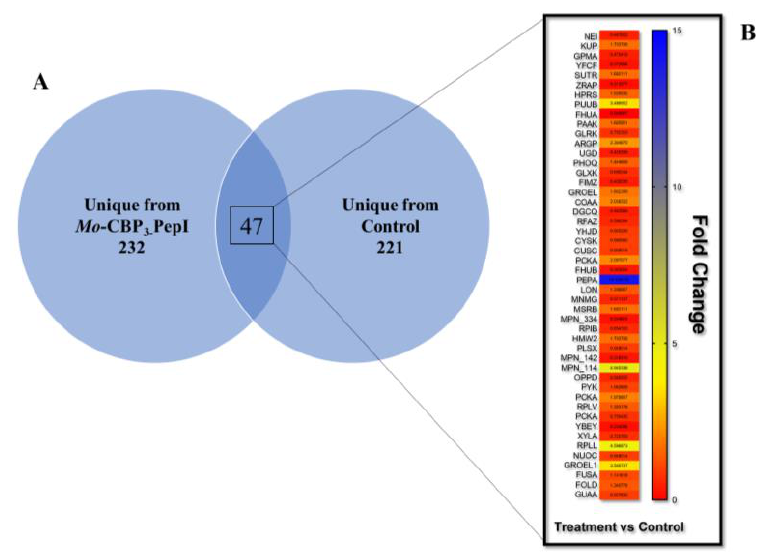
Figure 5. Distribution of K. pneumoniae proteins obtained after treatment with Mo -CBP 3 -PepI. ( A ) Venn diagram shows the dispersion of total proteins of control and Mo -CBP 3 -PepI-treated cells. ( B ) Represents the fold-change value of overlapping proteins, which were found in both groups. The vertical bar indicates the color scale according to each protein ’ s fold-change value.